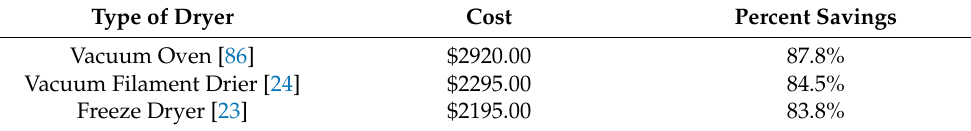
Table 8. Cost comparison of the open source vacuum oven with other devices on the